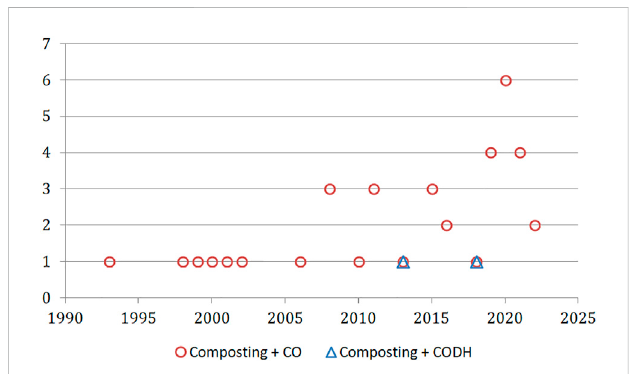
FIGURE 3 Thetimelineofpublishedresearchfor “ composting ” articlesrelated to CO and CODH (Web of Science Core Collection).